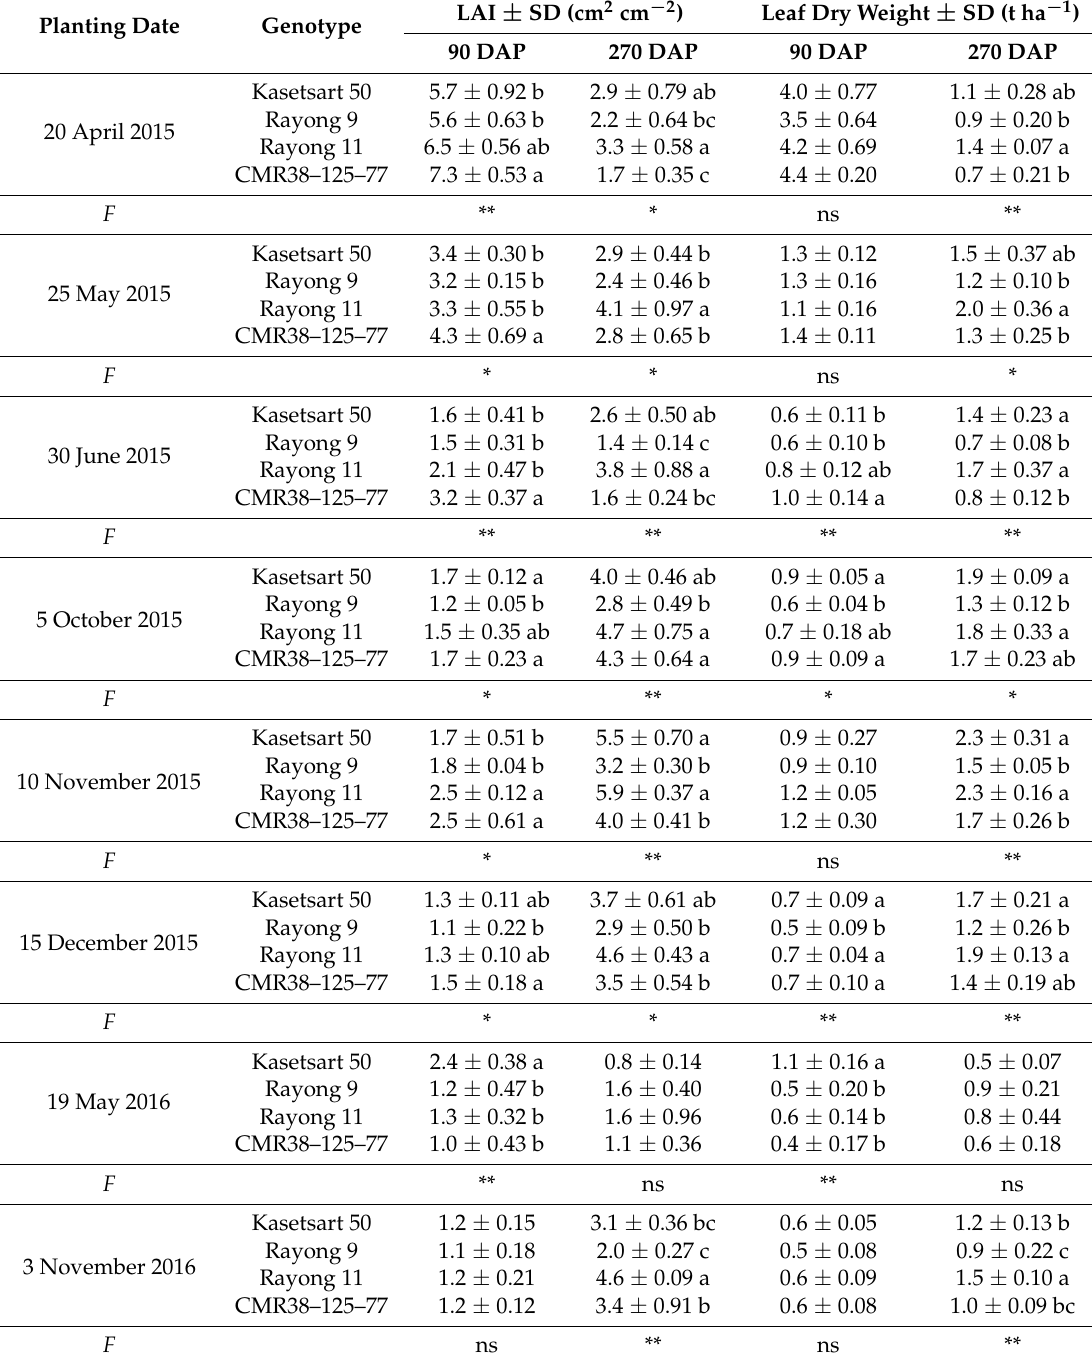
Table 4. Leaf area index (LAI) and leaf dry weight at 90 and 270 days after planting (DAP) for four genotypes grown on eight planting